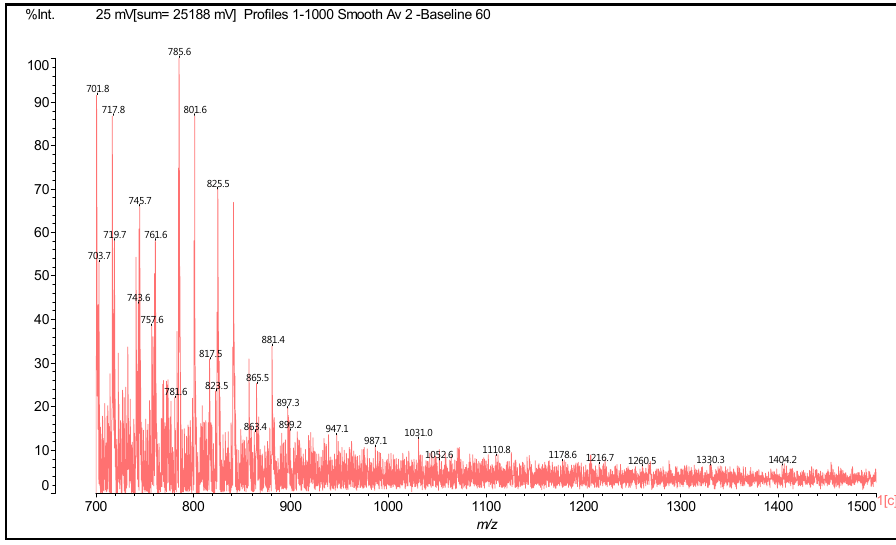
Figure 23. MALDI-ToF spectrum of the reaction of mimosa tannin extract with hexamethylene diamine at 100 °C, pTSA-catalysed. Range 700–1500 Da.